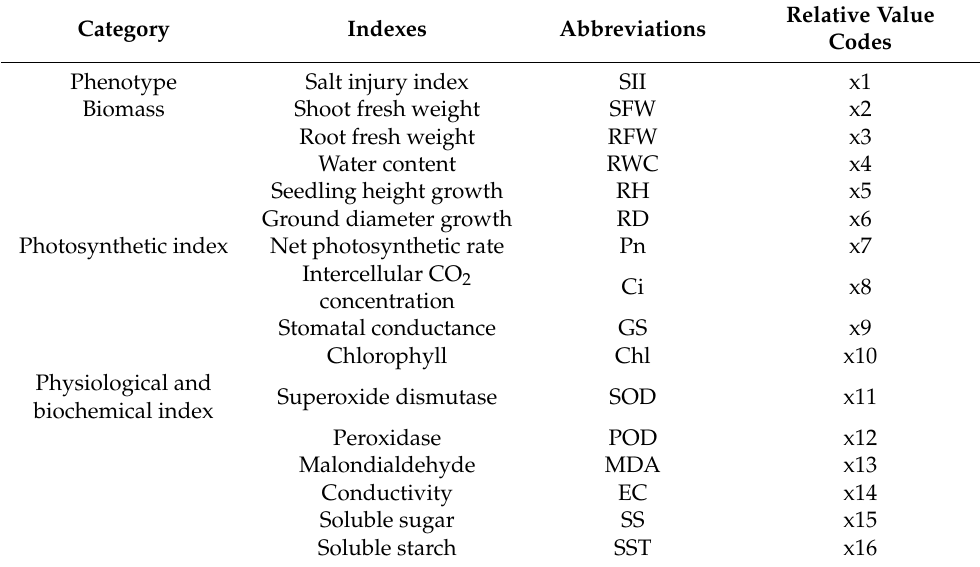
Table 1. Indexes for standard equation